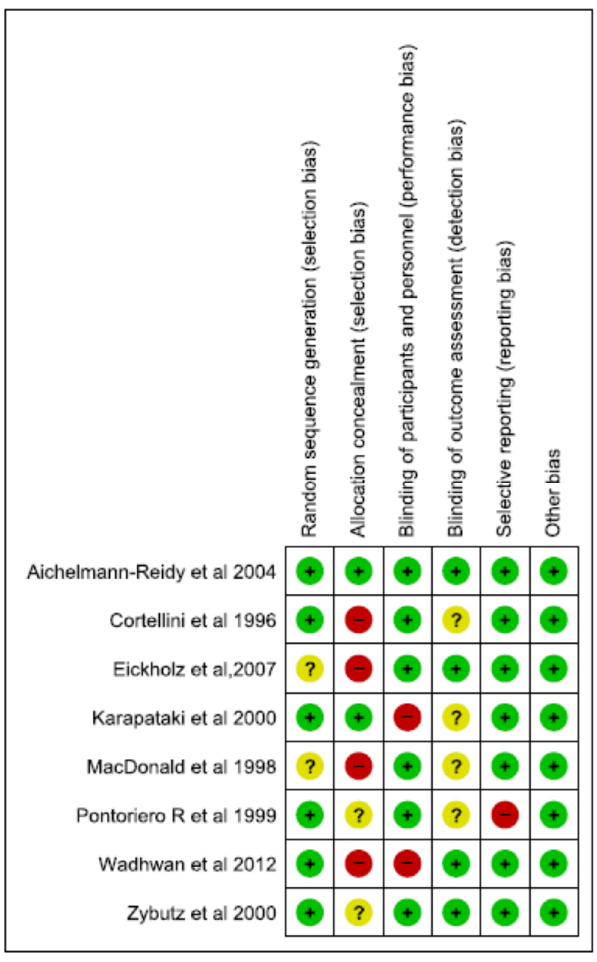
Figure 3. Risk of bias summary of all the included studies.